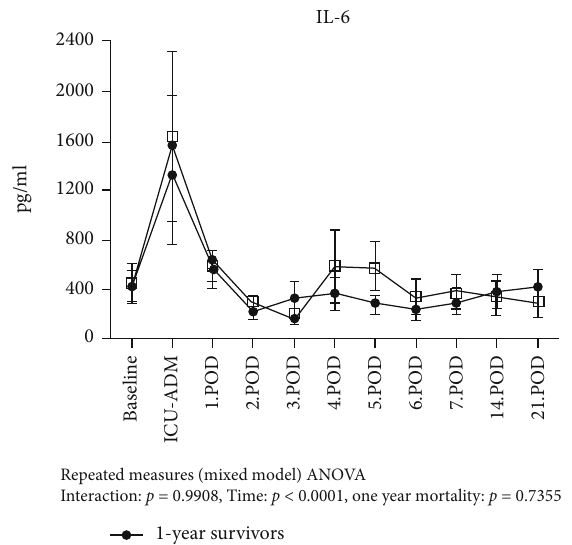
Figure 4: Temporal pattern of IL-33 in 1-year survivors and 1-year nonsurvivors. Given are the results of the ANOVA mixed model analysis for repeated measures.